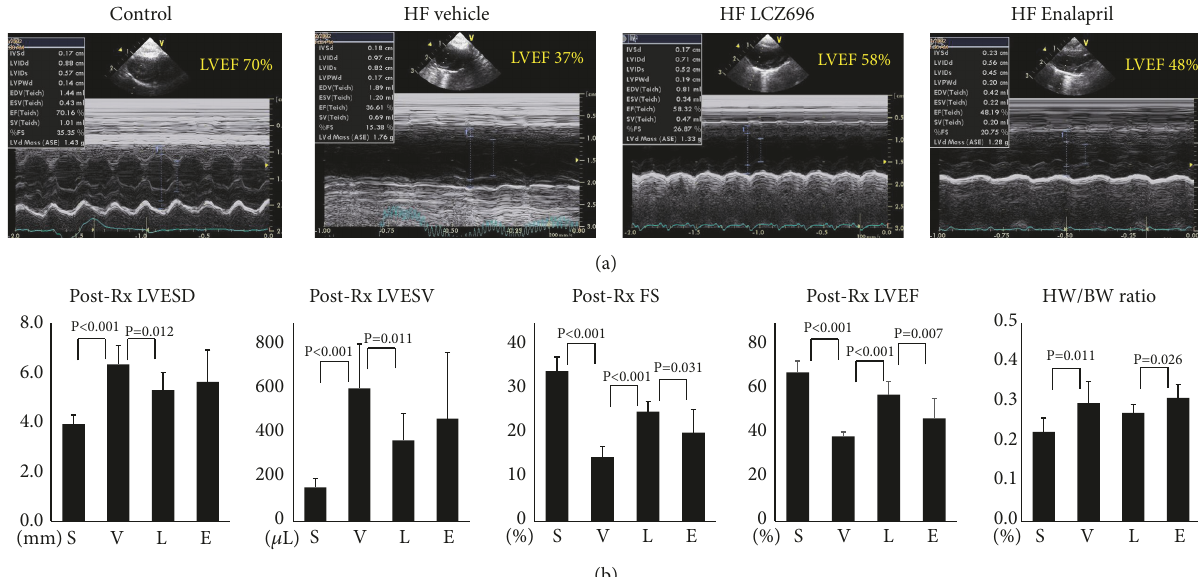
Figure 2: Results of echocardiography exams. (a) Representative examples of echocardiography exams. (b) Summarized results of left ventricular end-systolic diameter (LVESD) and left ventricular end-systolic volume (LVESV), fractional shortening (FS), left ventricular ejection fraction (LVEF), and heart weight (HW)/body weight (BW) ratio. Groups abbreviations: S, sham; V, vehicle; L, LCZ696; E